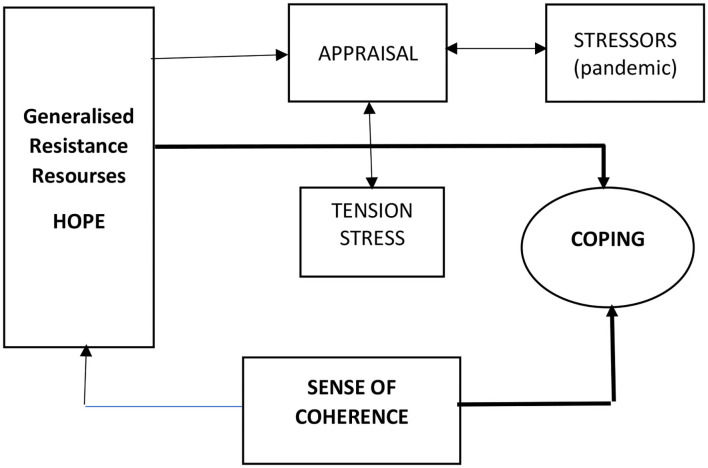
Studied variables in the model of salutogenesis (Antonovsky, 1979).